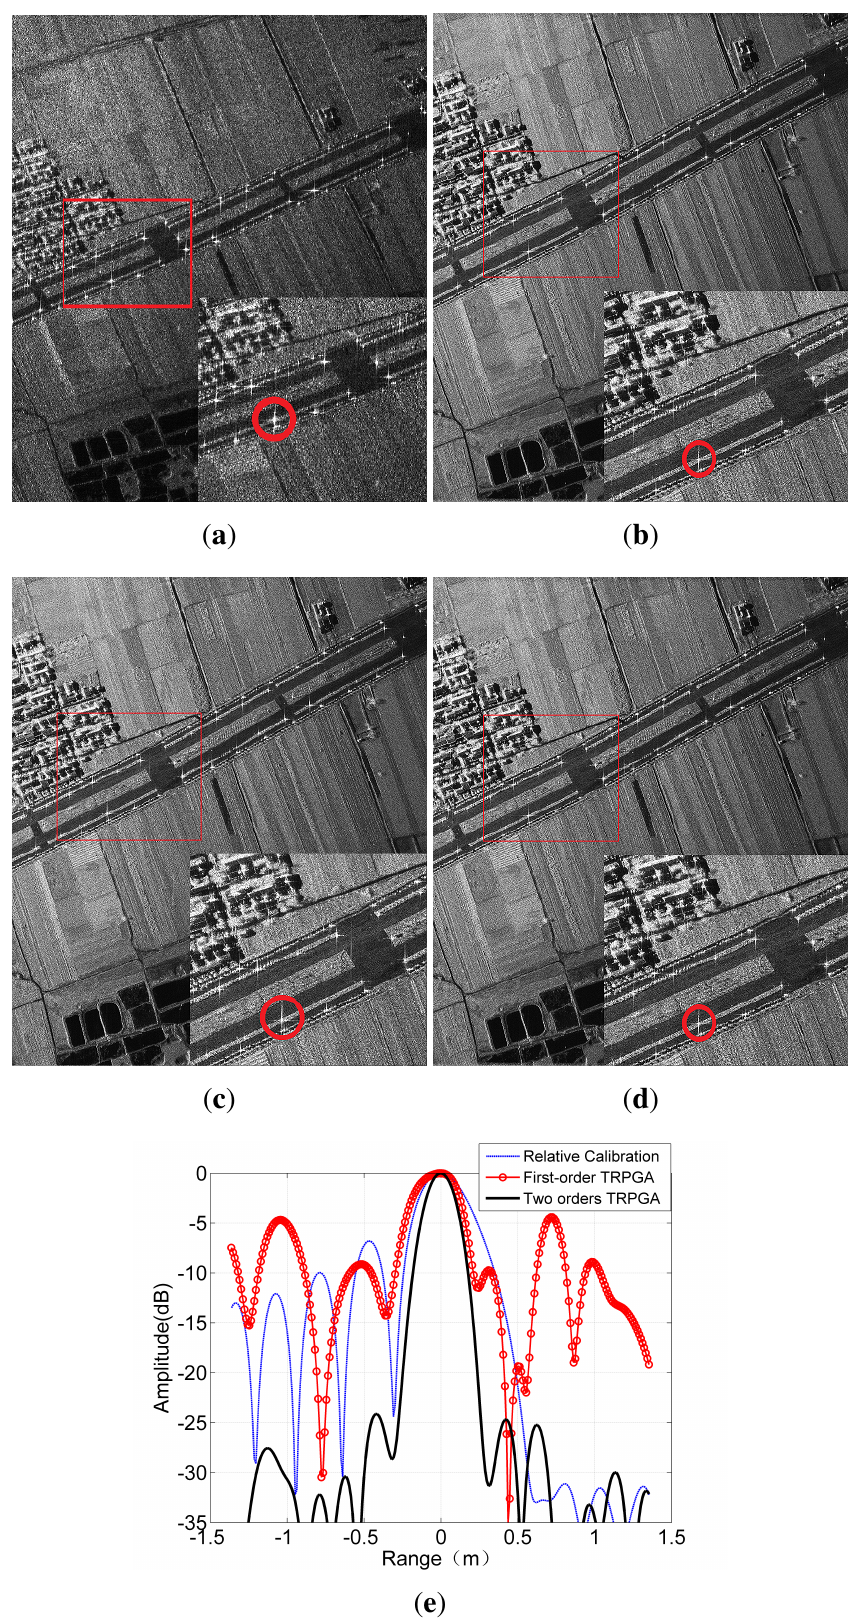
Figure 9. Imaging results based on collected real SAR data: ( a ) imaging result of sub-band signal; ( b ) imaging result of reconstruction with relative calibration; ( c ) imaging result of reconstruction of first-order TRPGA; ( d ) imaging result of reconstruction of two-order TRPGA; ( e ) range profile of point target in